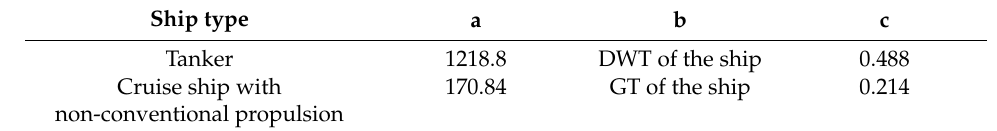
Table 6. Parameters for energy e ffi ciency design index (EEDI) reference value equation.